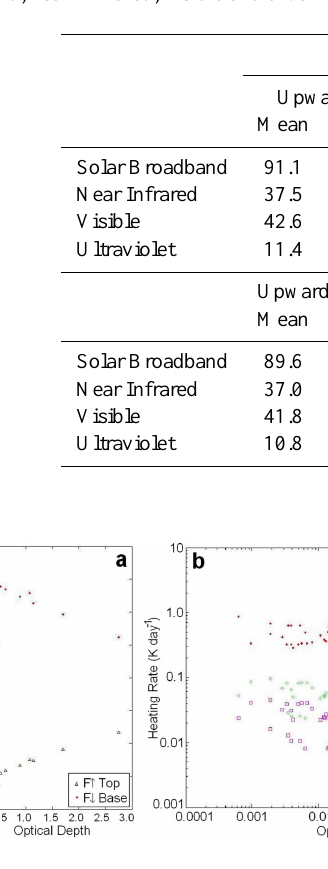
Fig. 4. (a) Broadband irradiances versus optical depths. Upward irradiance at the cloud top ( F ↑ Top) and downward irradiance at the cloud base ( F ↓ Base), for all studied clouds. (b) Daily Mean Heating rates for all studied cirrus clouds at each spectral solar band versus their optical